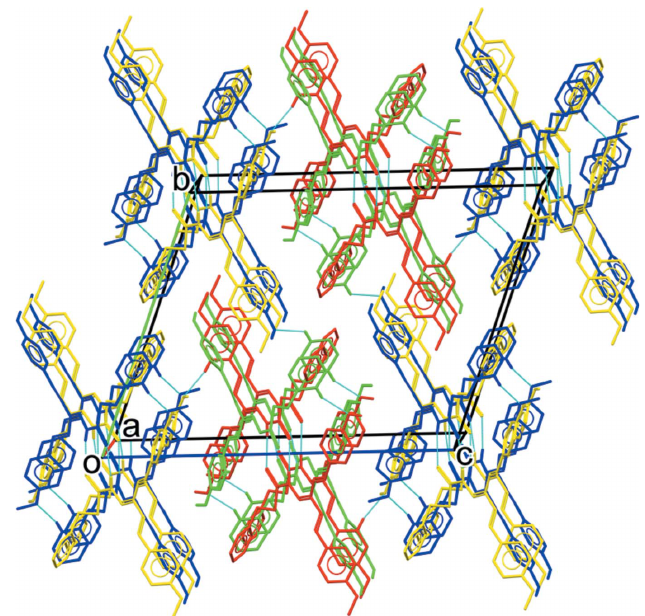
Figure 5 The overall packing of the title compound, viewed approximately along the a- axis